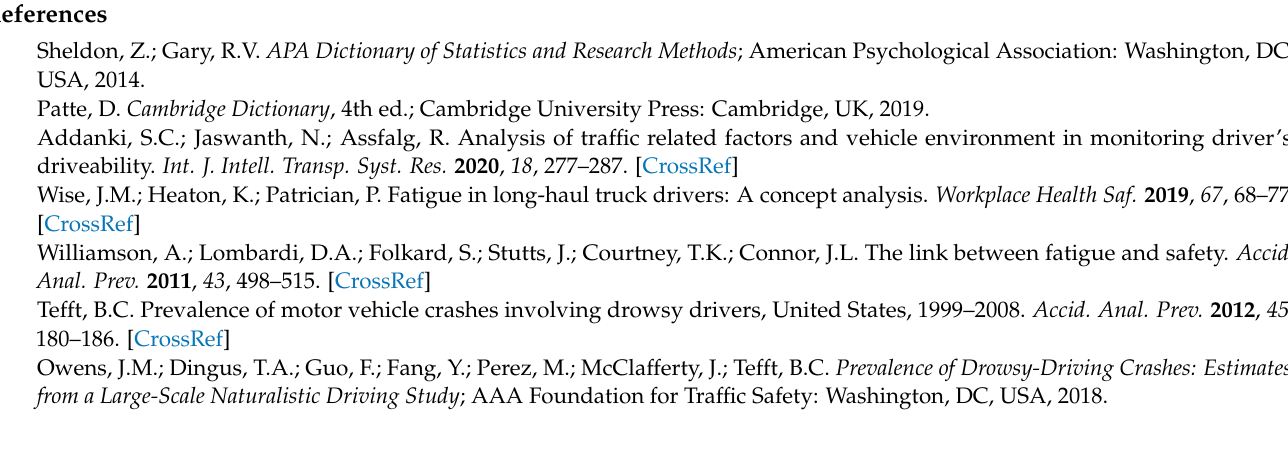
Figure A1. The eye blinks detected from the glass ( left panel ) and EyeLink ( right panel ) data recorded from Subject #1. Red lines represent the eye area data from our glasses; Green lines represent the pupil area data from the EyeLink eye-tracker. The detected blinks are marked with gray strips.